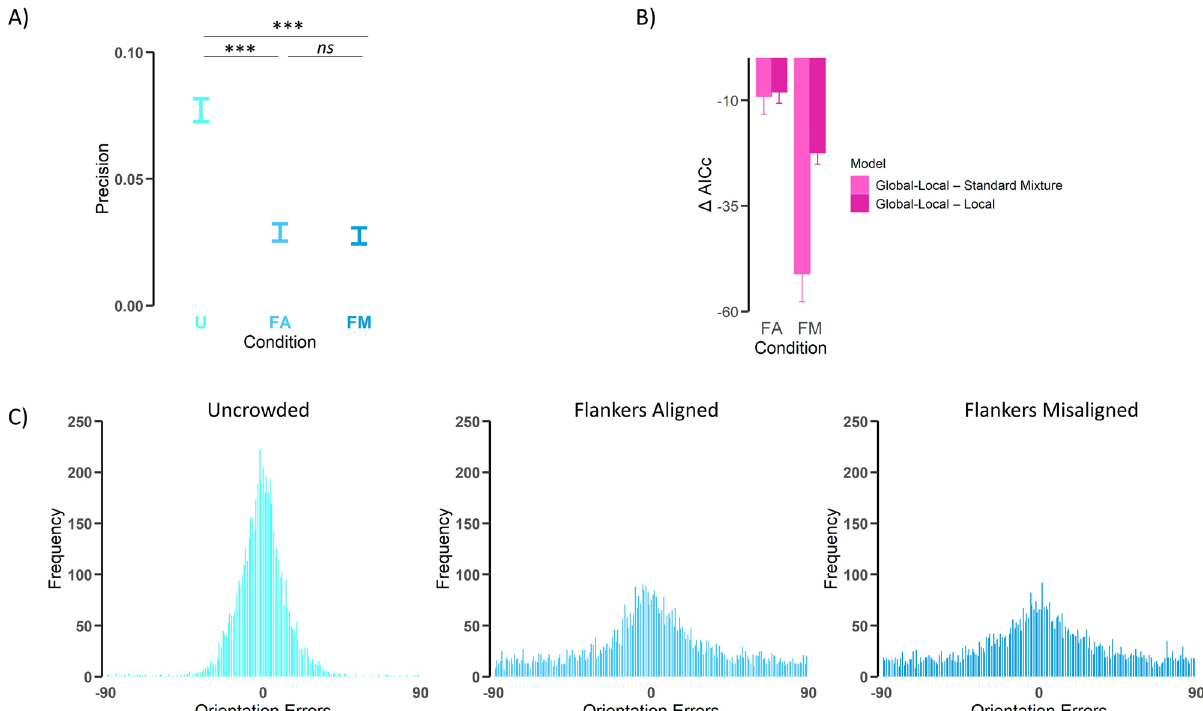
Figure 2. Error distributions, model comparison and precision. (A) Mean precision (inversed SD in degrees) of the errors in each display condition, U uncrowded, FA flankers aligned, FM flankers misaligned. (B) ∆AICc comparisons for each flanker condition. In both conditions the Global–Local model outperformed both the Standard Mixture and the Local models (lower AICc indicates better model fit). ∆AICcs was calculated by subtracting the AICc of both Standard Mixture and Local models from that of the Global–Local model (AICc Global–local – AICc StandardMixture , AICc Global–local – AICc Local ). (C) Frequency of errors (reported value minus true value of the target) for each of the three display conditions. Note that because flankers were uniformly distributed compared to the target, misreports rates form a uniform shape in the plot. Error bars represent standard